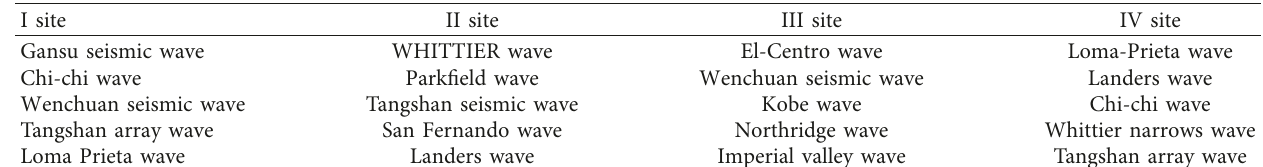
Figure 2: Full bridge finite element model. (a) Single beam. (b) Double beam. (c) Multi-beam. Table 4: Ground motion records of various